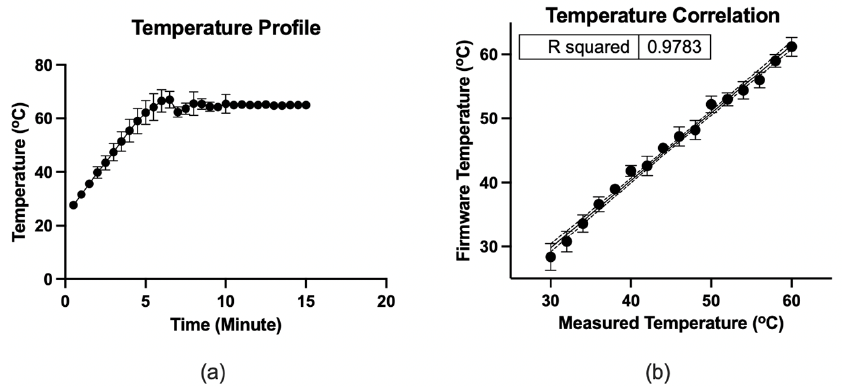
Figure 6. ( a ) Temperature profile of the micro-heater. ( b ) Correlation between the firmware readout and the measured thermometer by IR thermometer, where n = 5. The dots indicate the mean, and the error bars represent the standard deviation.